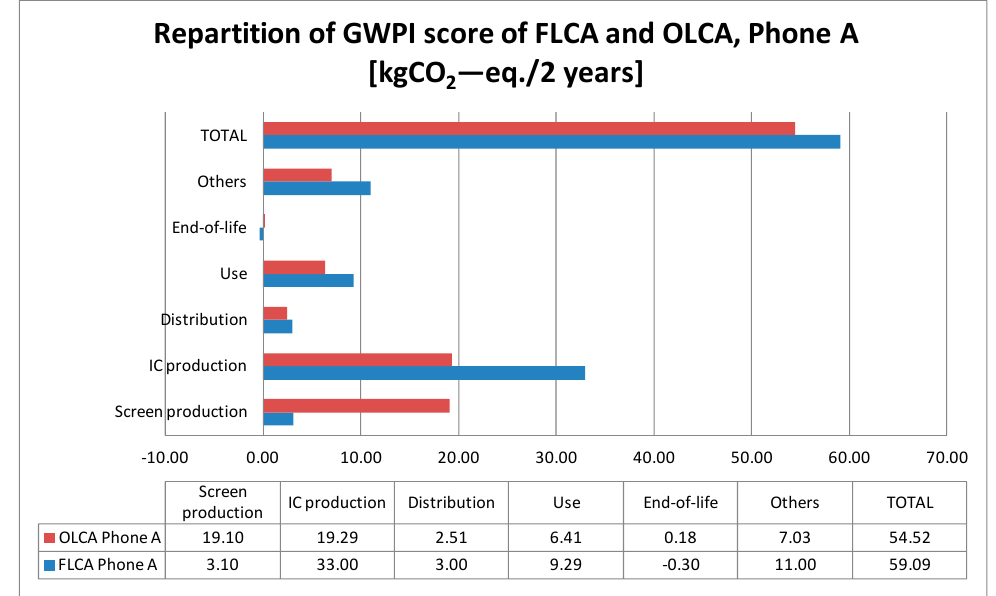
Figure 8. Repartition for FLCA and OLCA GWPI scores for Phone A.